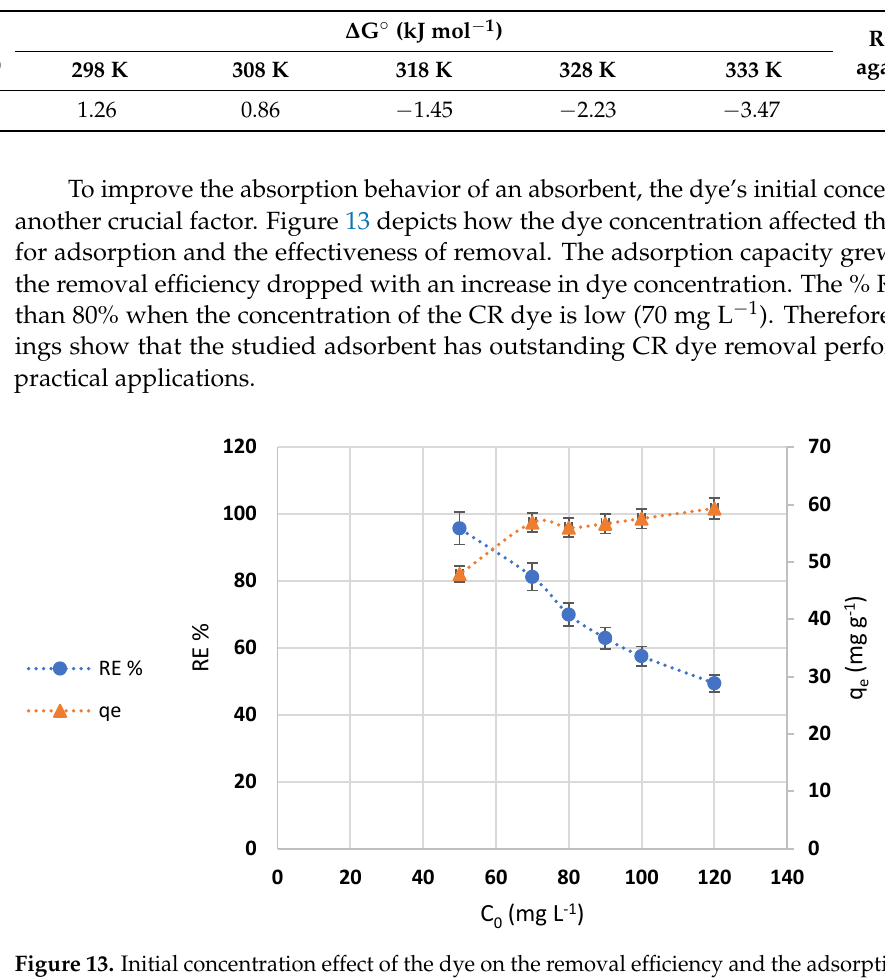
Figure 13. Initial concentration effect of the dye on the removal efficiency and the adsorption capac- ity (m = 0.01 g, V = 10 mL, pH=4, T = 328 K, and time = 48